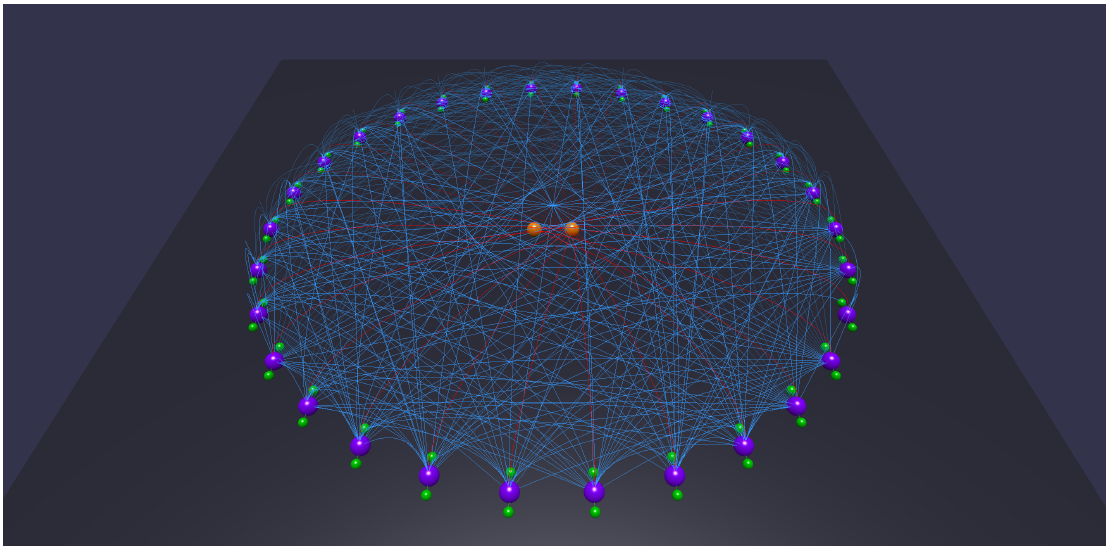
Figure 6. Full knowledge base of the Use Case